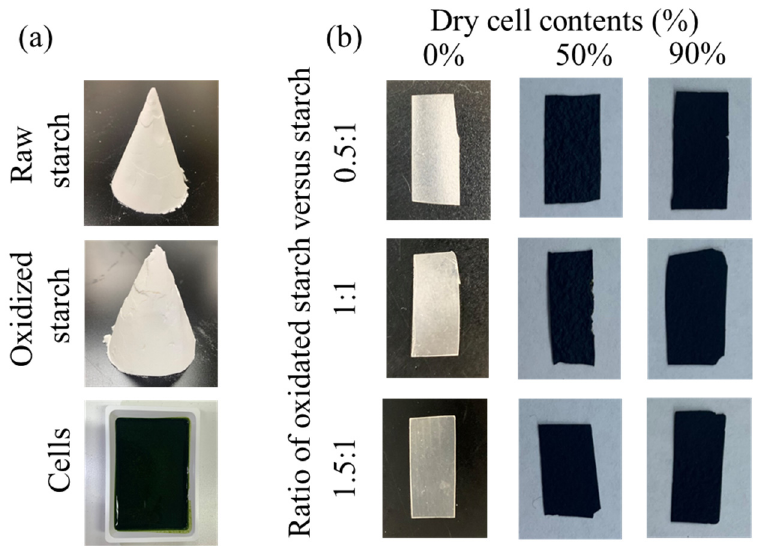
Figure 1. Pictures of starch cell-plastics, starch and cells. ( a ) Components of starch cell-plastics. ( b ) Starch cell-plastics.